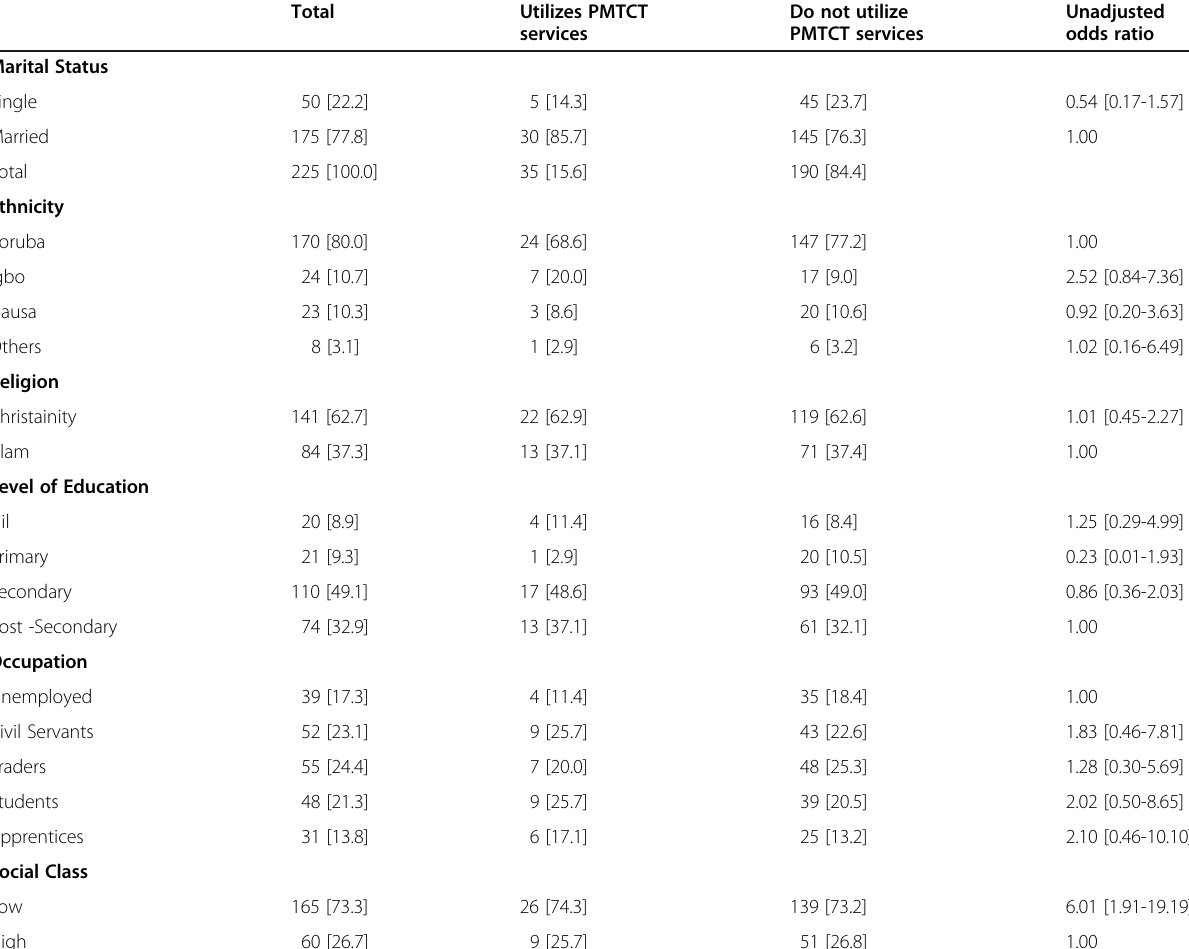
Table 4 Factors associated with utilization of PMTCT services